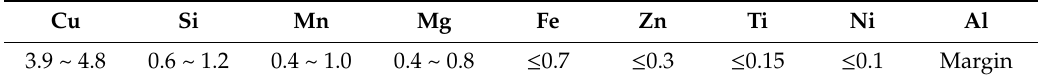
Table 2. Chemical composition of 2A14 Aluminum